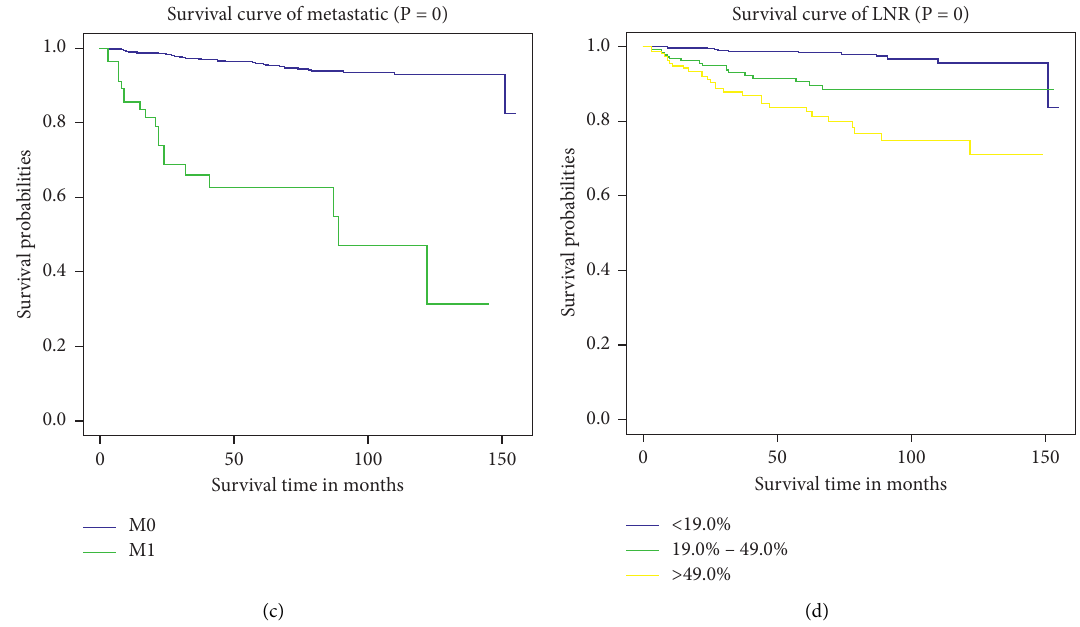
Figure 5: Kaplan–Meier survival curves of meaningful independent predictors: (a) age, (b) tumor size, (c) metastasis status, and (d) LNR about cancer-specific survival (CSS) in the training